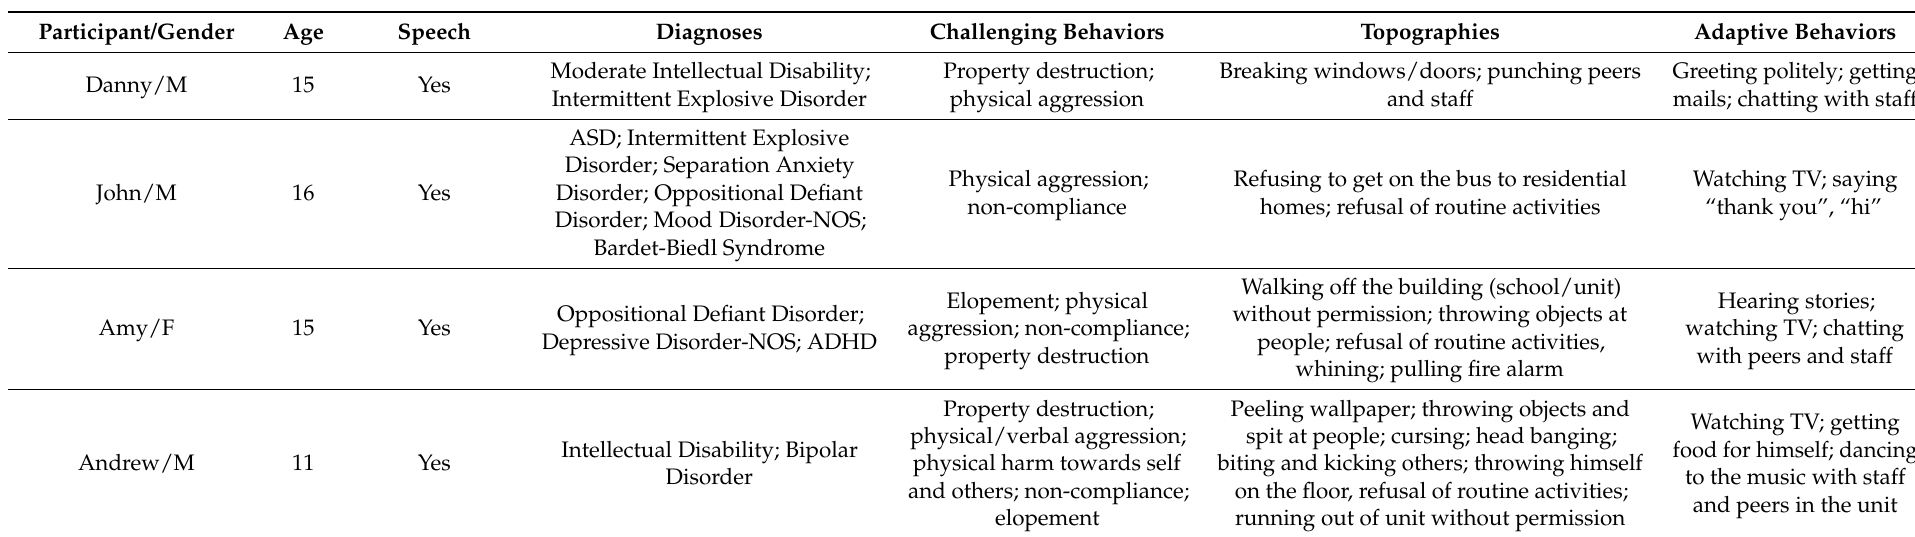
Table 1. Characteristics of